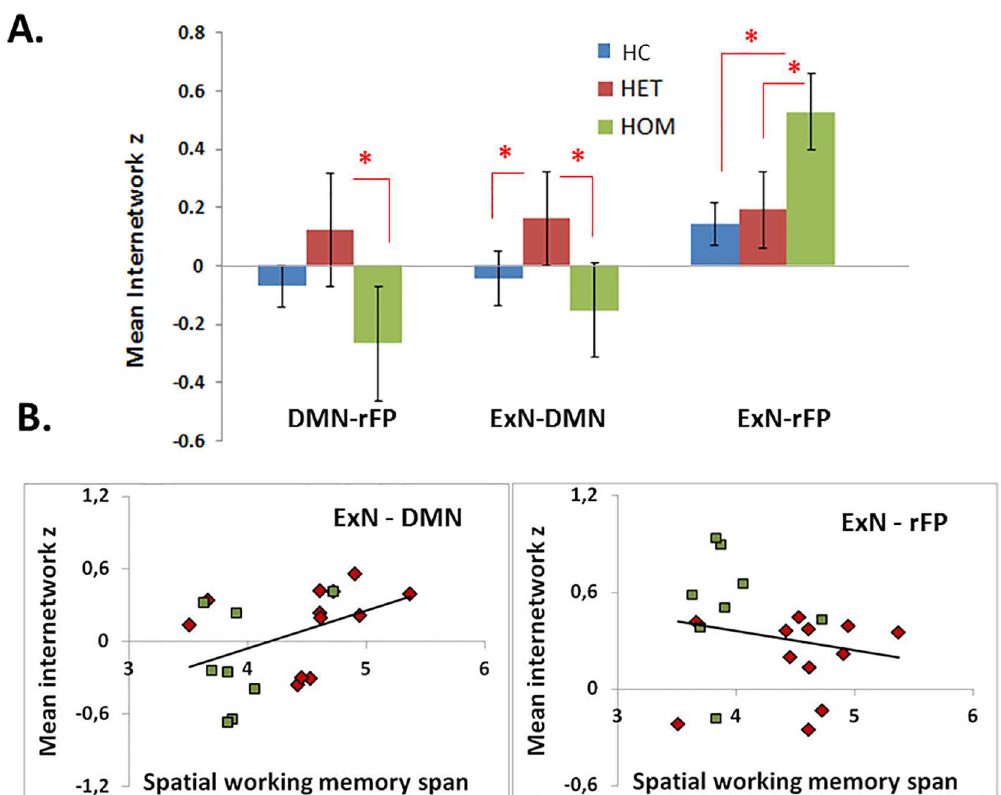
Fig 3. Inter-network analysis. Panel A shows the mean (SD) internetwork z scores for each studied group (i.e., healthy controls, HC; homozygous (HOM) and heterozygous (HET) mutation carriers) in three pairs of networks: salience network and right fronto-temporal network (SN-rFP); default mode network and right fronto-temporal network (DMN—rFP); saliencenetwork and default mode network (SN-DMN). Asterisks highlightsignificant between-group differences. Panel B illustrates the significant correlations, obtained in HOM (green-square marks) and HET (red-rhomb marks) mutation carriers altogether, between mean internetwork z scores in SN-rFP and SN-DMN pairs of networks and individualscores obtained at Corsi test (spatial working memory